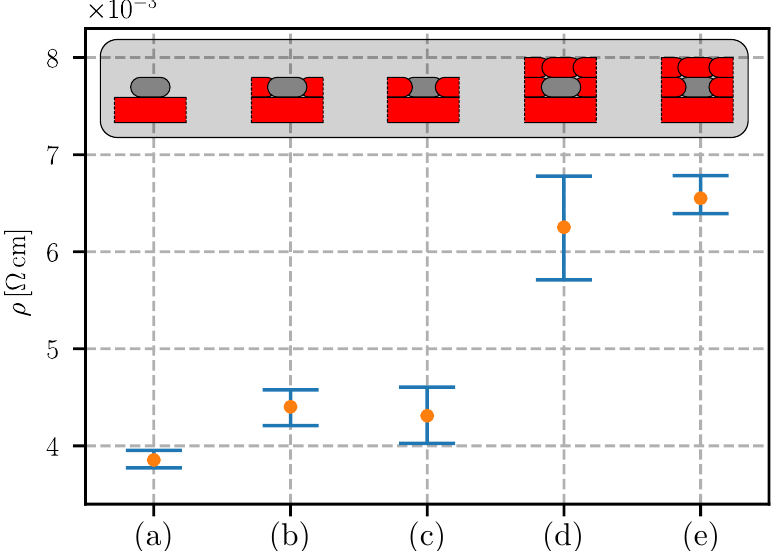
Figure 18. Effect of PLA insulating traces (letters corresponding to Figure 7); sample sections are added for